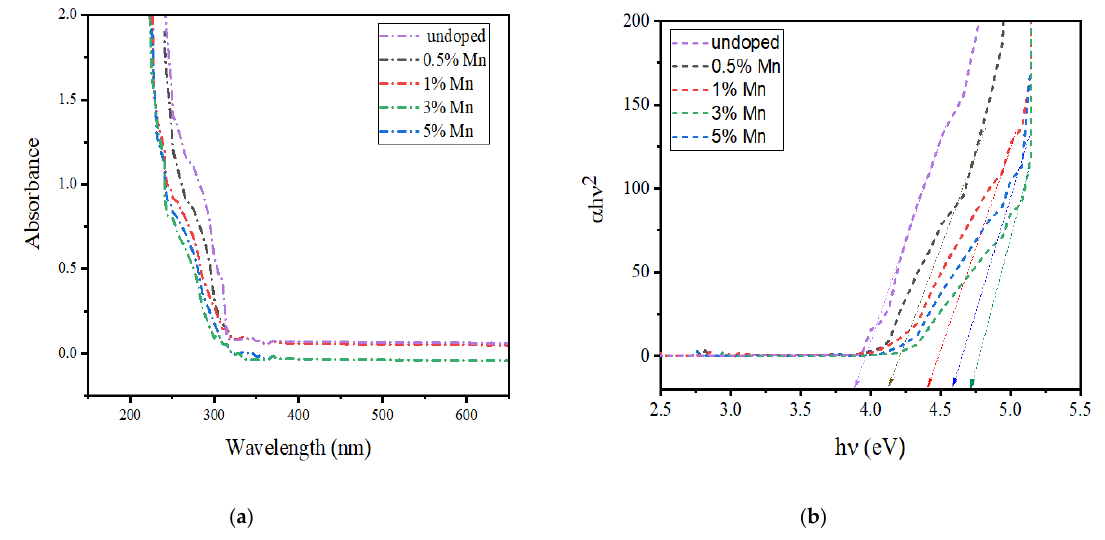
Figure 7. ( a ) UV-visible absorption spectra of Mn:ZnS QDs. ( b ) Band gap energy curve of Mn:ZnS QDs.